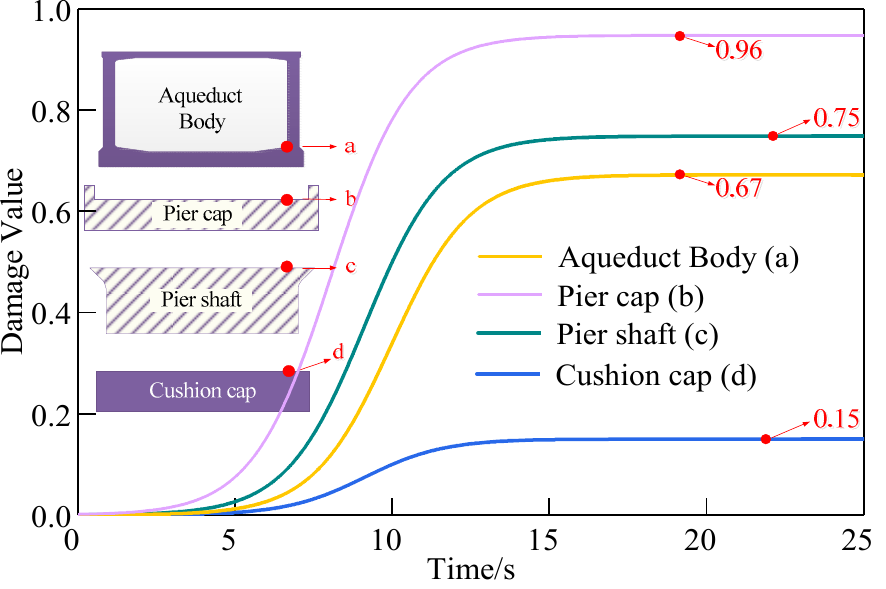
Figure 5. Damage development process.